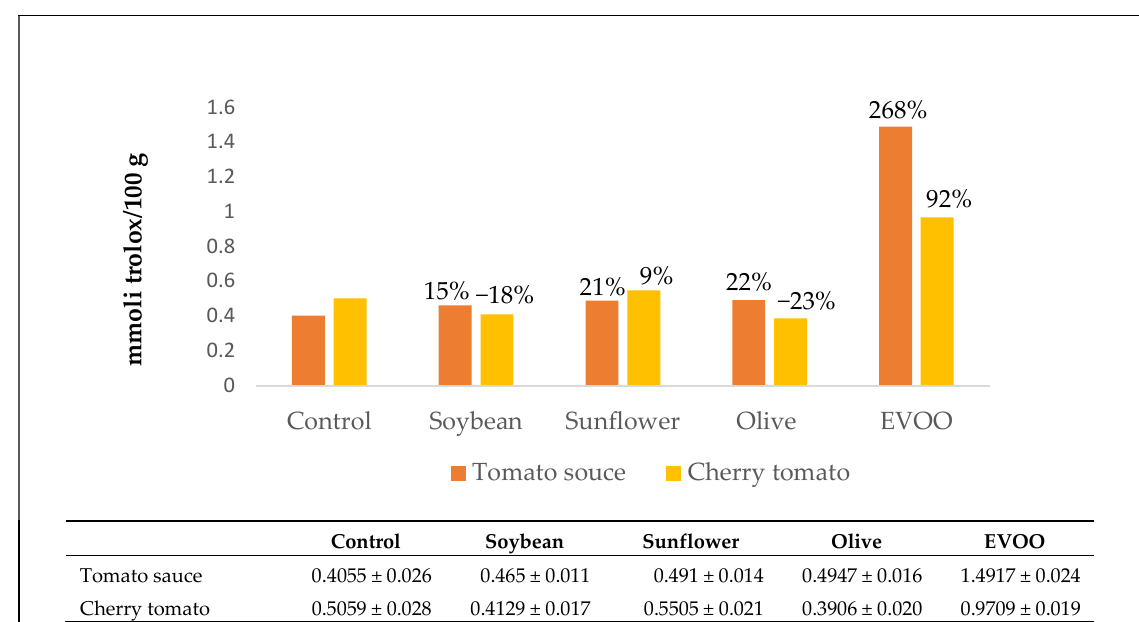
Figure 4. Antioxidant activity of the carotenoid extracts.